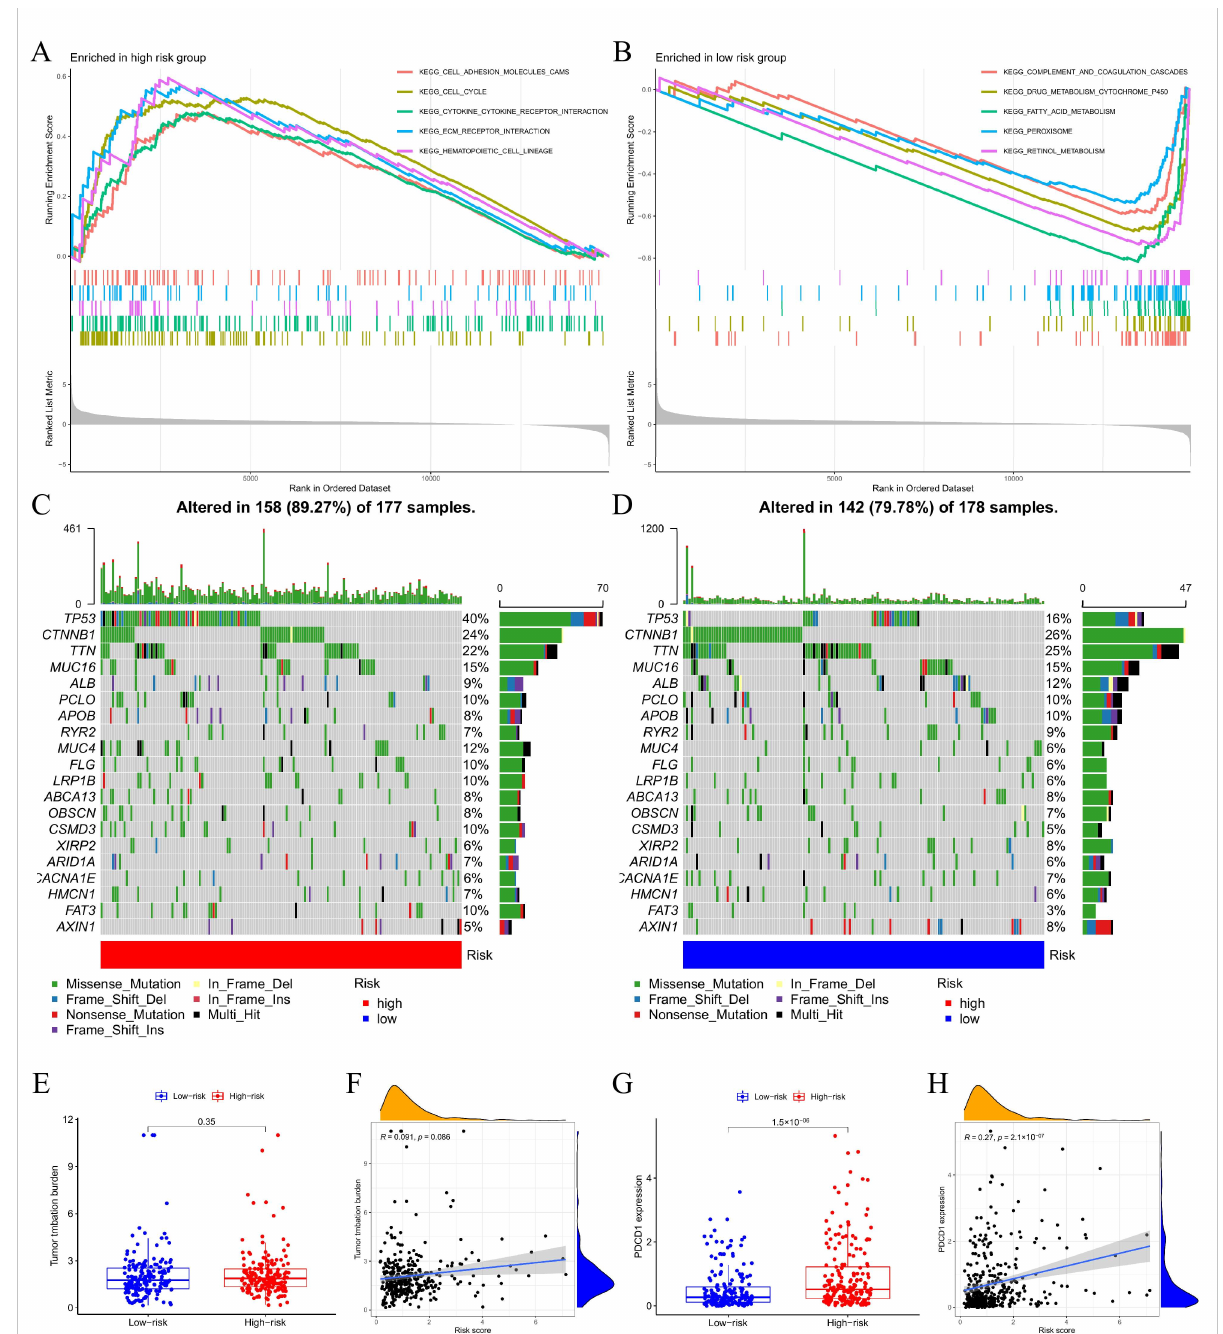
Figure 6. Molecular characteristics of different DRGPI subgroups. ( A ) Gene sets enriched in DRGPI- high subgroup. ( B ) Gene sets enriched in DRGPI-low subgroup. Gene mutation analysis showed that mutation count in the high DRGPI subgroup ( C ) was significantly higher than that in the low DRGPI subgroup ( D ). ( E , F ) Correlation analysis between DRGPI score and total mutational burden (TMB). ( G , H ) Correlation analysis between DRGPI score and PD-L1